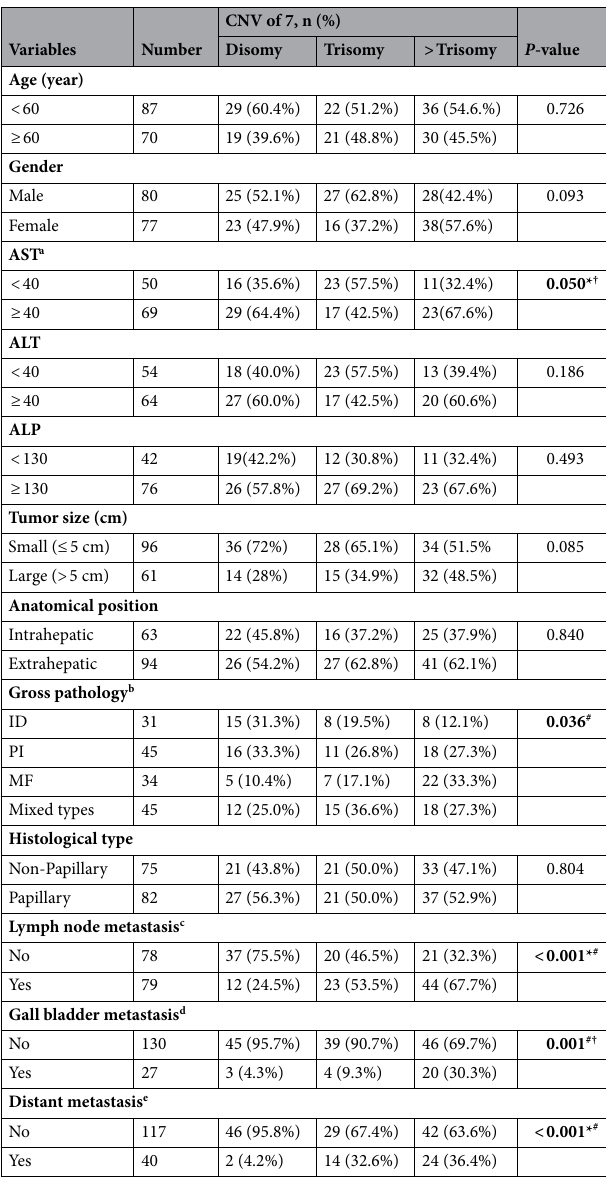
Table 1. The correlation of clinicopathological characteristics of CCA patients with chromosome 7 copy number variants. *P < 0.05 Disomy vs Trisomy; # P < 0.05 Disomy vs > Trisomy; † P < 0.05 Trisomy vs > Trisomy. a AST: Disomy vs Trisomy; P = 0.043, Trisomy vs > Trisomy; P = 0.031. b Gross pathology: Disomy vs > Trisomy; P = 0.009. c Lymnode Metastasis: Disomy vs Trisomy; P = 0.004, Disomy vs > Trisomy; P < 0.001. d Gall bladder Metastasis: Disomy vs > Trisomy; P = 0.001, vs > Trisomy; P = 0.009. e Distant Metastasis: Disomy vs Trisomy; P < 0.001, Disomy vs > Trisomy; P <